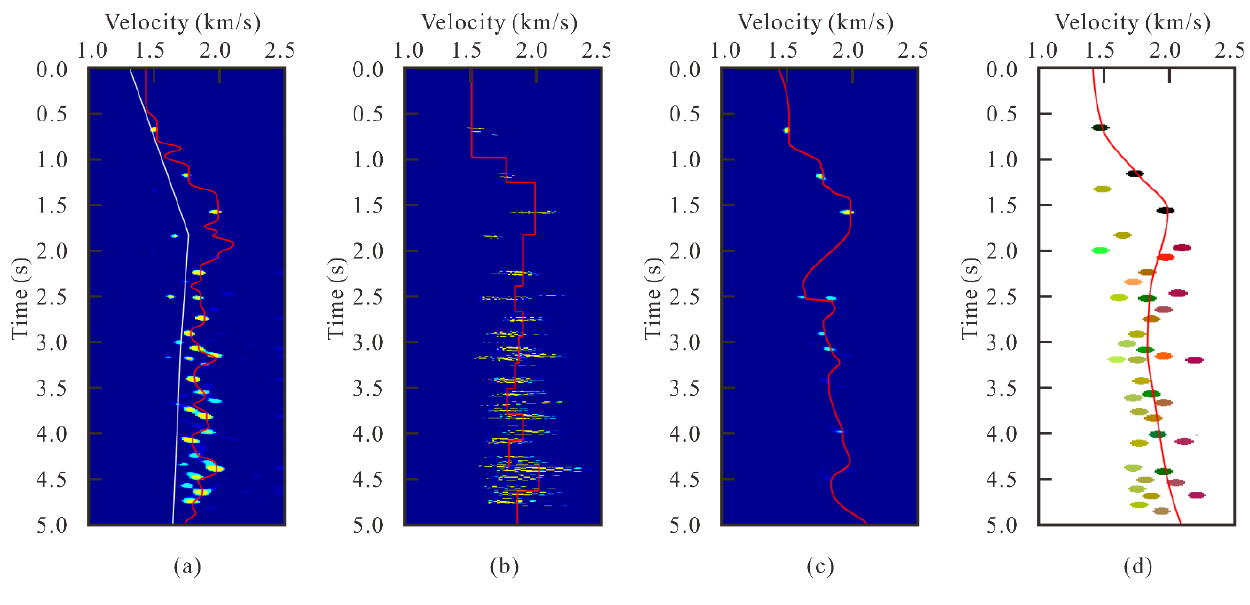
Figure 5. Display of synthetic data test results: ( a ) muting-based strategy (MU), ( b ) Radon transform strategy (RT), ( c ) multiple attenuation strategy (MA), ( d ) proposed advanced method (AD).